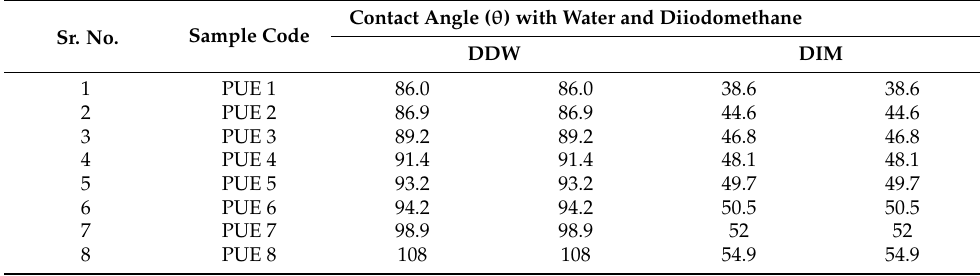
Table 3. Contact angle’s variation with DDW and DIM, sorted by increasing molecular weight of